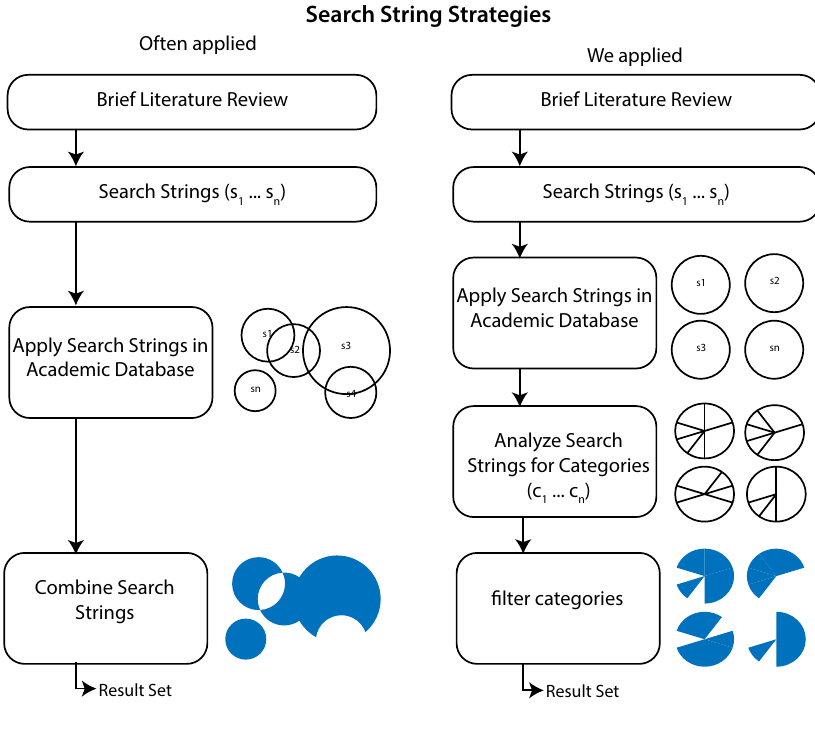
Figure 3. Applied Search